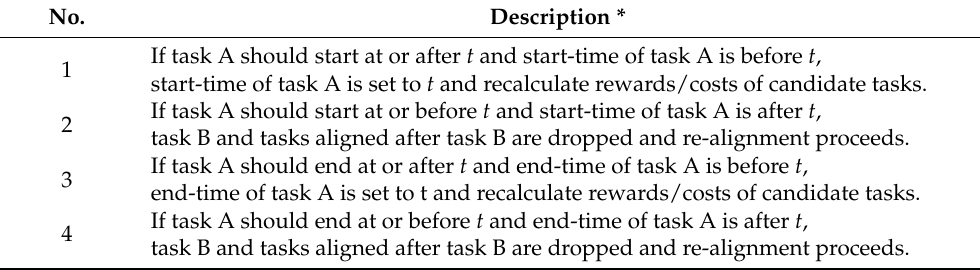
Table 5. Basic rules for scheduling.